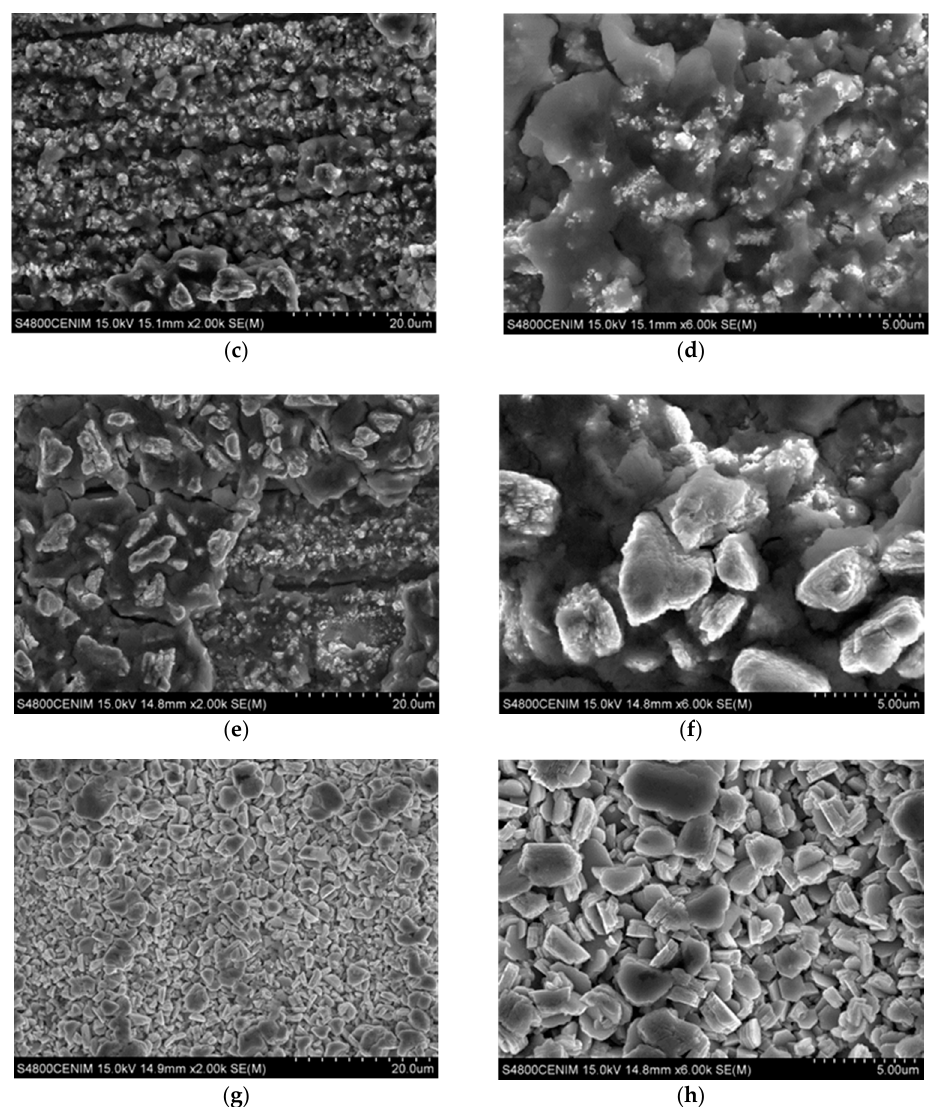
Figure 4. Scanning electron microscopy (SEM) images taken at different position of the Hull cell specimen obtained in 0.3 M ZnCl 2 –0.1 M CeCl 3 –ChCl–Urea: ( a ) dark gray area (zone I); ×2000; ( b ) ×6000; ( c ) Intense dark blue area (zone II-a), ×2000; ( d ) ×6000; ( e ) dark blue area (zone II-b) ×2000; ( f ) ×6000; ( g ) light gray area (zone III) ×2000; and ( h ) ×6000.